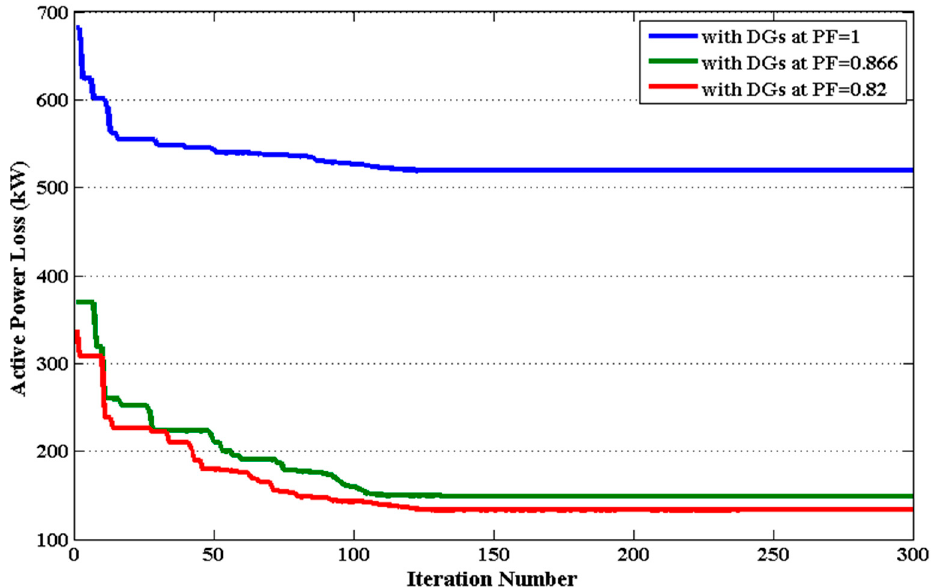
Figure 15. Convergence characteristics for Case 1 of the IEEE 118-bus system using QODELFA.